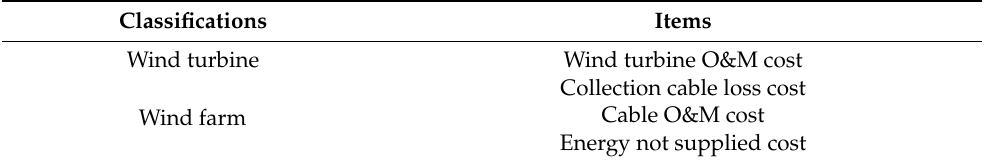
Table 9. Items used to calculate the operating expenditure (OPEX) of the